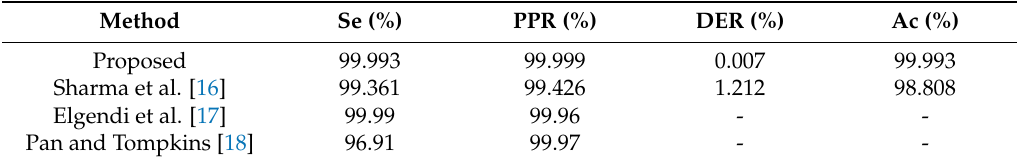
Table 5. Performance comparison with the MIT-BIH NSR database.